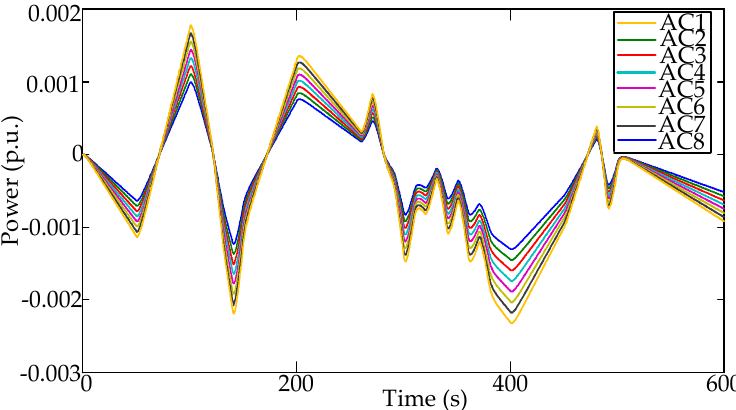
Figure 15. The power output of individual ACs under different control schemes.